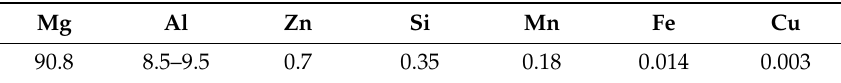
Table 1. Composition of AZ91 magnesium alloy (wt